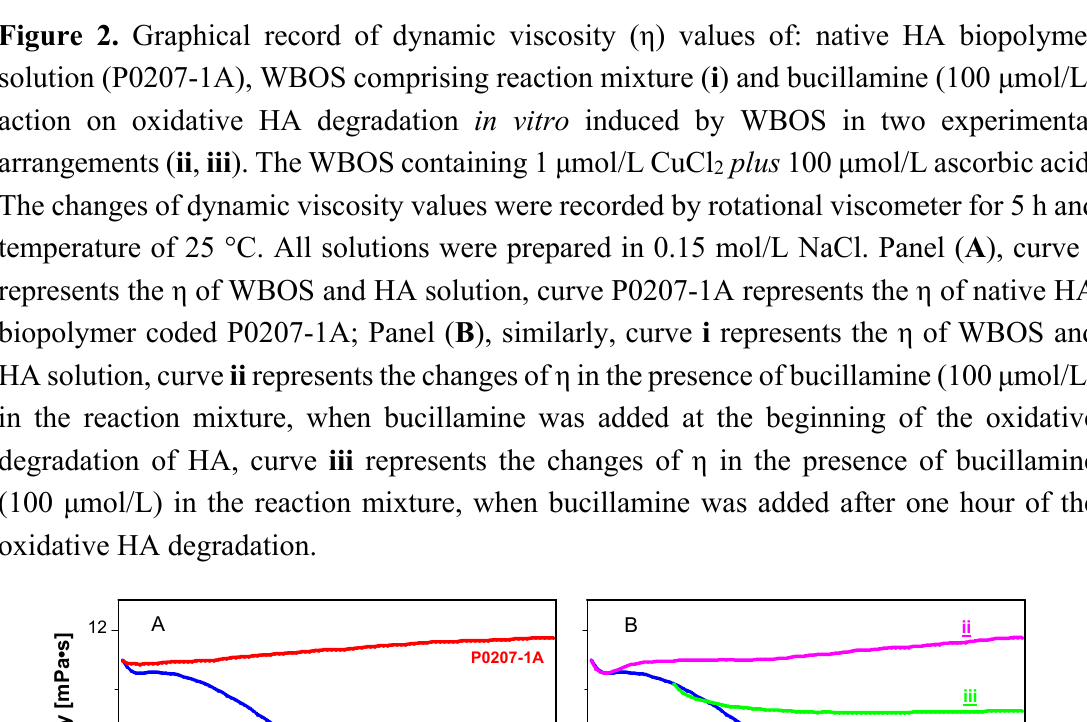
Figure 2. Graphical record of dynamic viscosity ( η ) values of: native HA biopolymer solution (P0207-1A), WBOS comprising reaction mixture ( i ) and bucillamine (100 μ